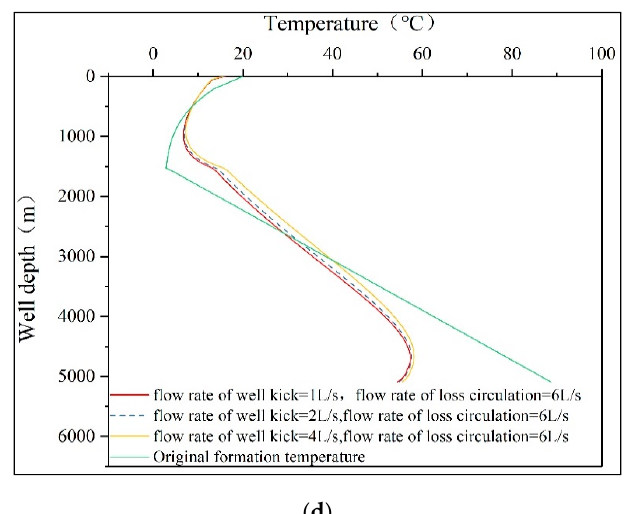
Figure 11. Annulus temperature distribution at different overflow and leakage rates when multi- system occurs. ( a ) The flow rate of overflow is greater than that of leakage when the multi-pressure system is located in the middle open hole formation; ( b ) The flow rate of overflow is less than that of leakage when the multi pressure system is located in middle open hole formation; ( c ) The overflow rate is greater than leakage rate when the multi pressure system is located at bottom hole; ( d ) The flow rate of overflow is less than that of leakage when the multi pressure system is located at bottom hole.